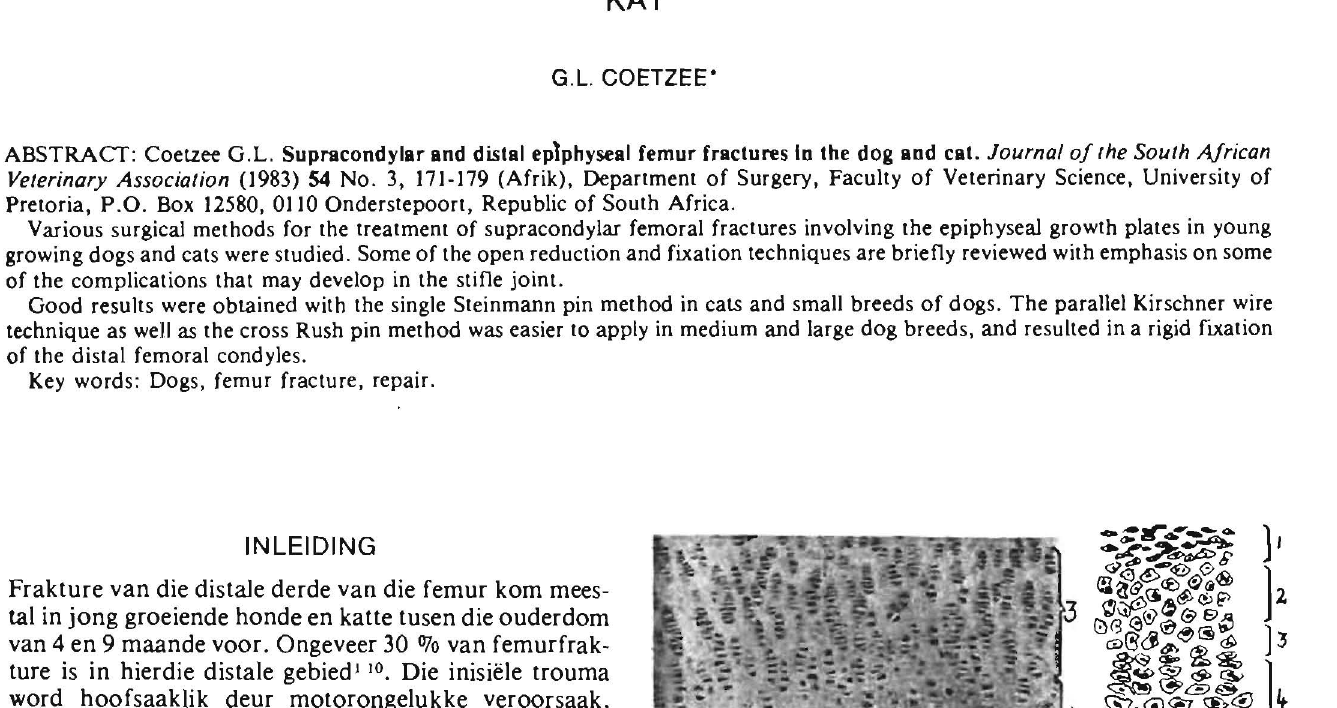
Fig. 1: Epifiseale groeiplaal. H.E. X125 Sone waar volwasse chondrosiete in rye begin rang· skik (3) Sone van hipertrofiese chondrosiete met piknotiese kernveranderinge, vakuoolvorming in die sitoplasma, opswelling en afsterwing (4) Sone waar afgestorwe chondrosie en matriks gekalsi· fiseer word (gekalsifiseerde kraakbeenlaag) (5) Metafiseale osteosiete en trabeculae